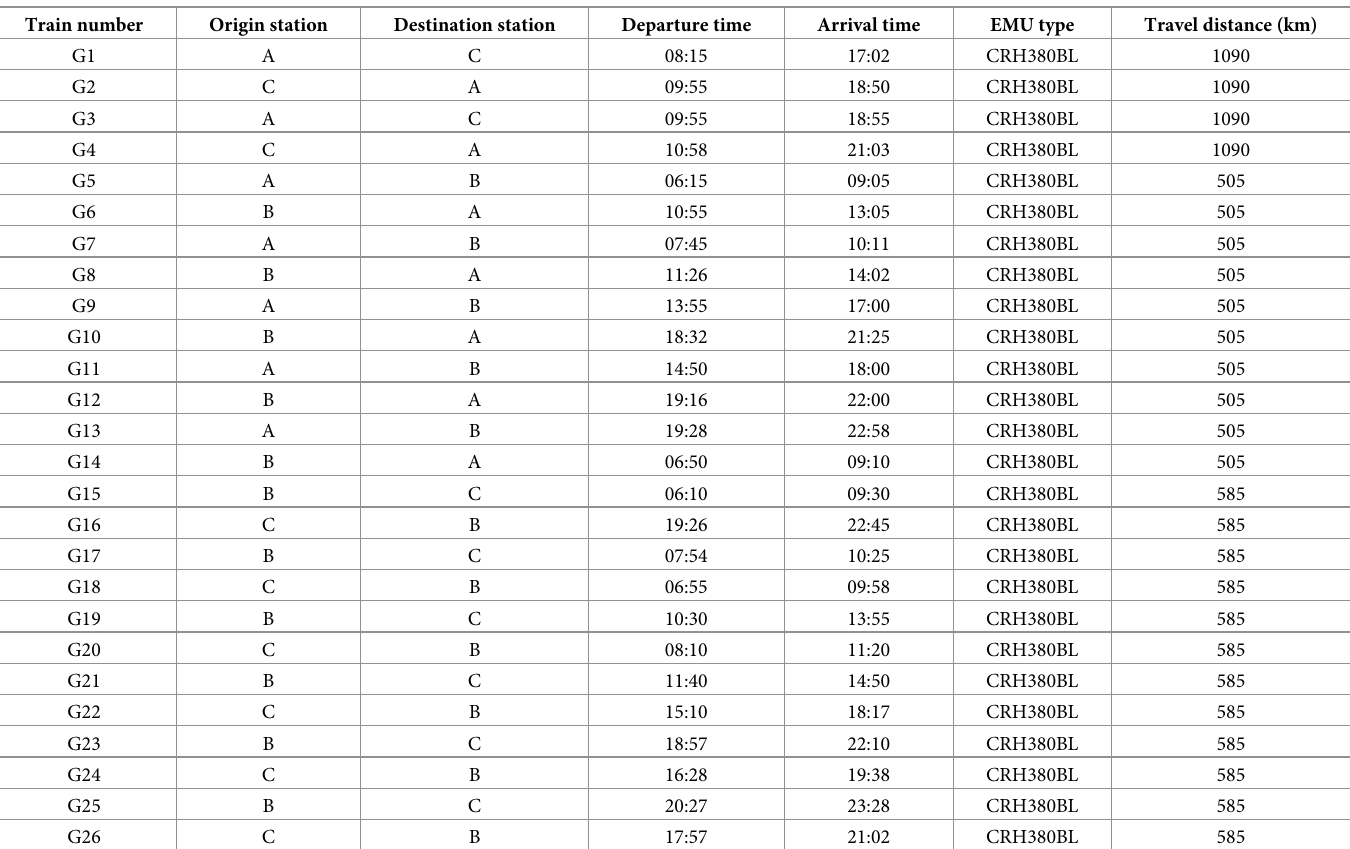
Table 6. Train information for the simple